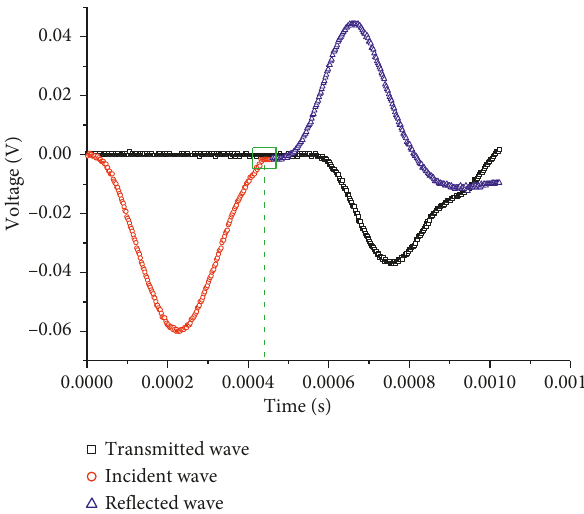
Figure 5: Typical incident wave shape and duration.